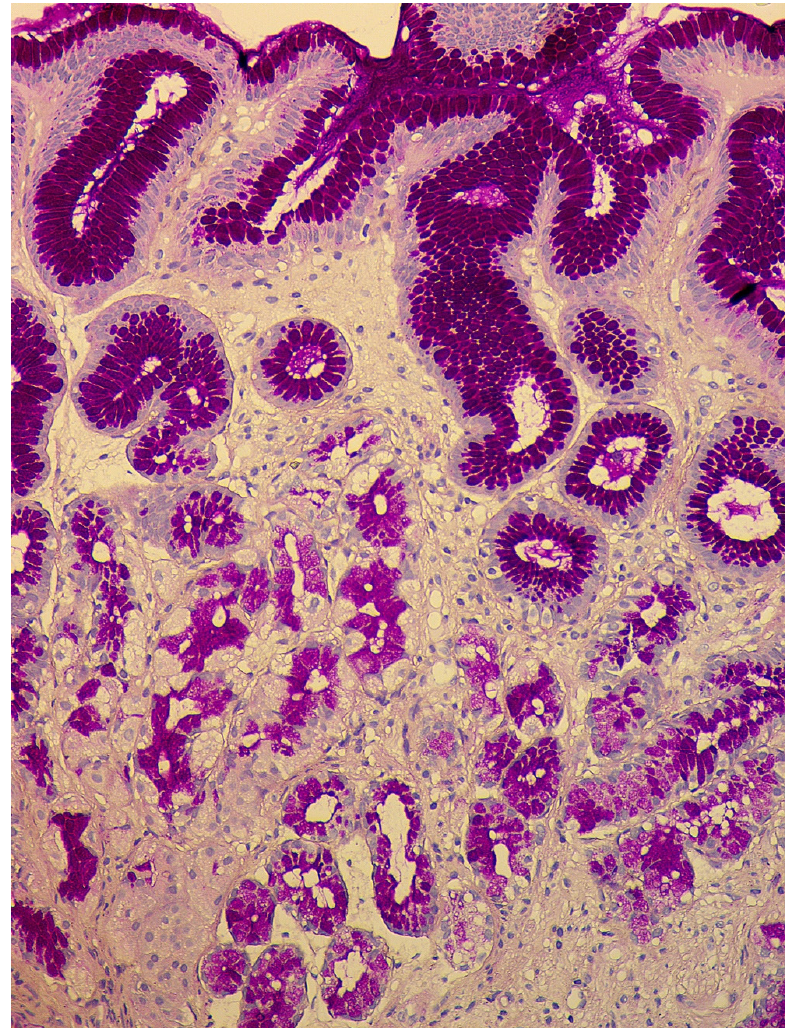
Figure 2. Autoimmune gastritis. Biopsy from the gastric body. Severe pseudopyloric metaplasia with the appearance of mucus-producing cells in place of the fundic glands (cytoplasm magenta staining). Periodic acid-Schiff stain. ×200 (from the personal archive of Professor S.I. Mozgovoi).